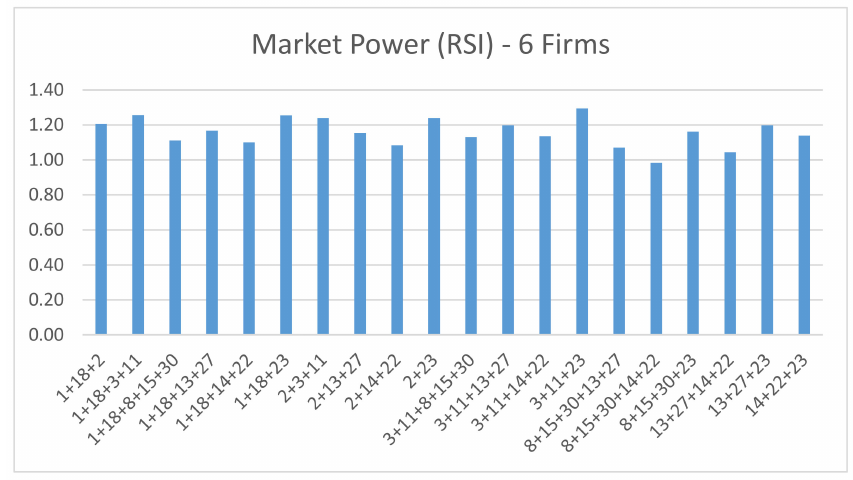
Figure 11. RSI for 6 firms’ setting (PC).